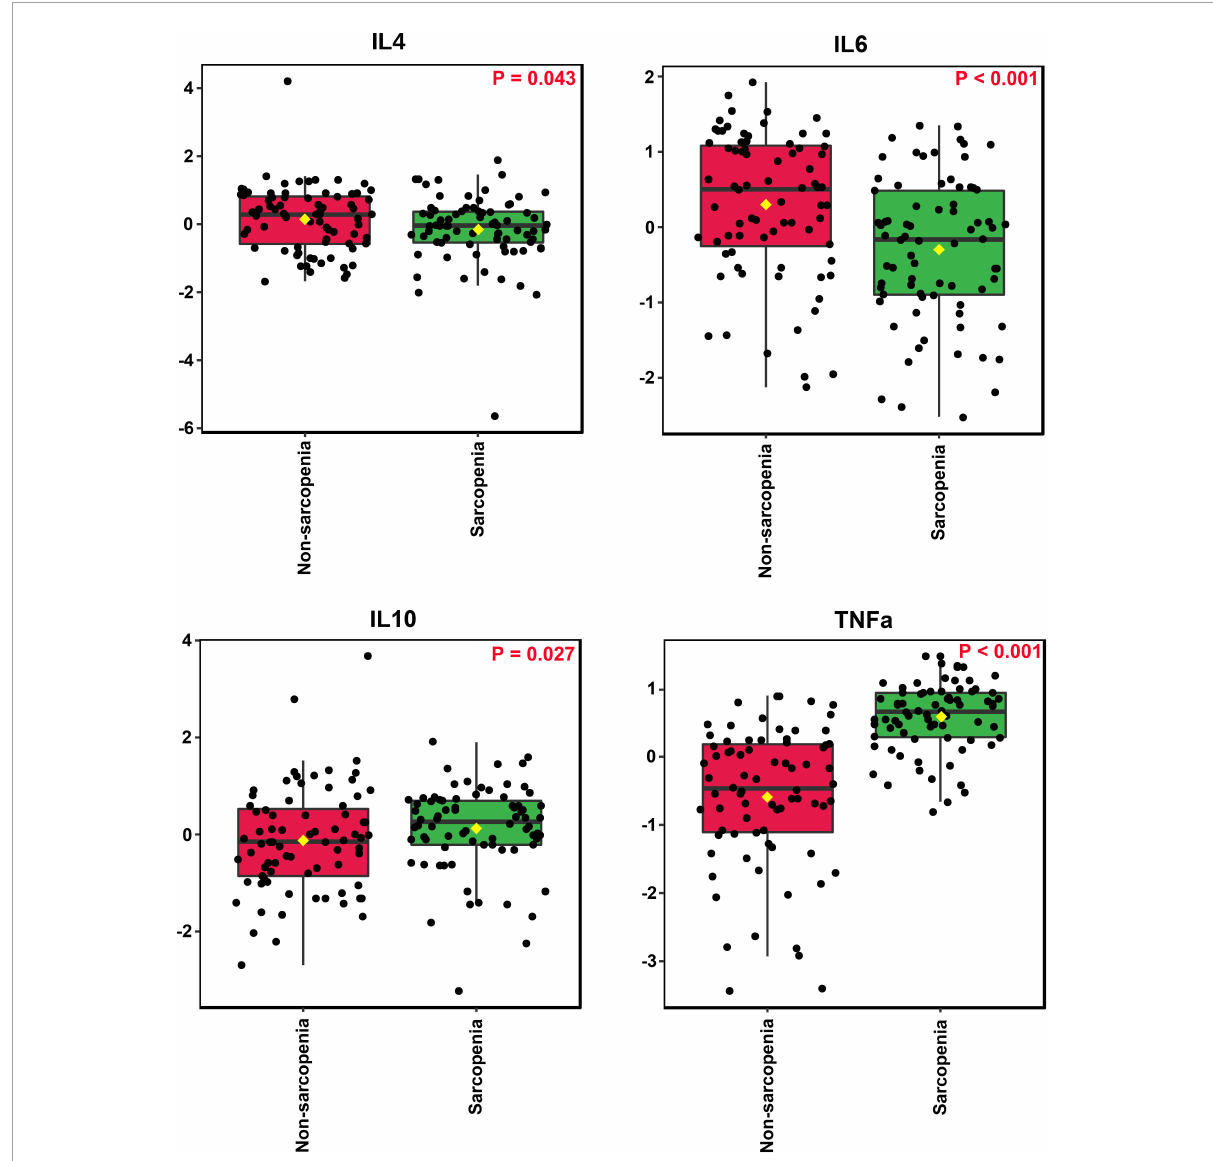
FIGURE2 Comparison of the inflammatory cytokines of all individuals with and without